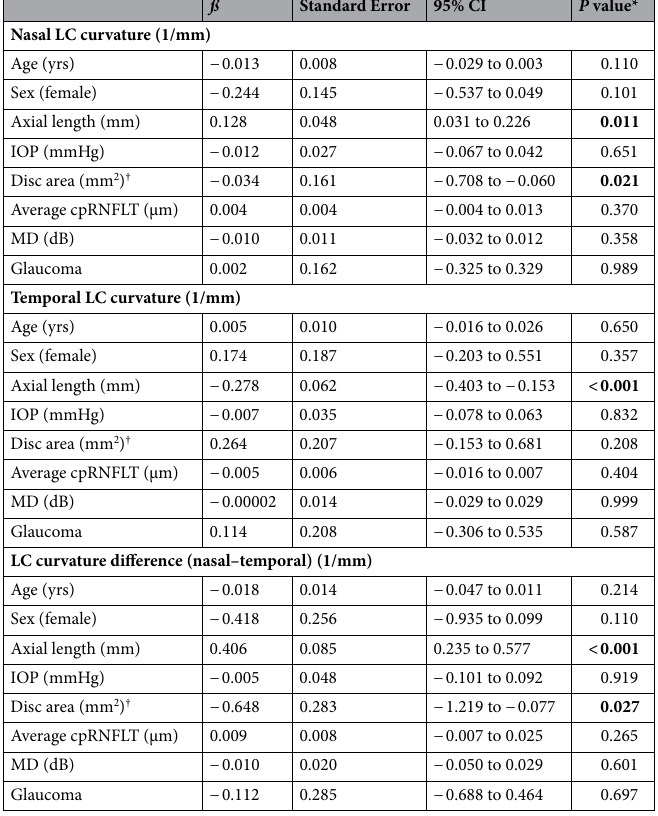
Table 4. Factors associated with LC curvature parameters. *Statistical analysis was performed using multivariate linear regression model. † Corrected area calculated in consideration of the magnification factors related to the SD-OCT camera and the eye by substituting the subject’s axial length. Statistically significant values are shown in bold ( P <